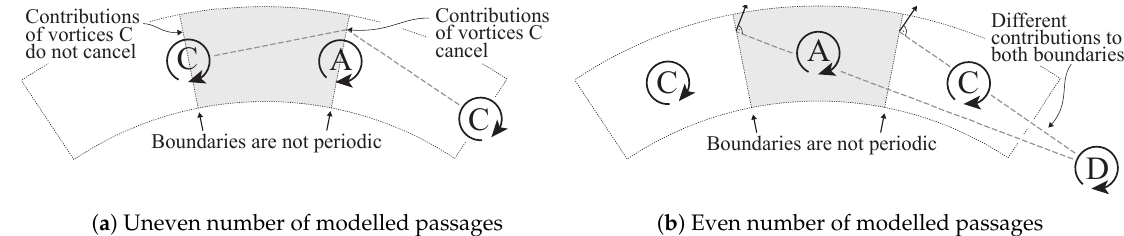
Figure 4. Periodicity of boundaries.